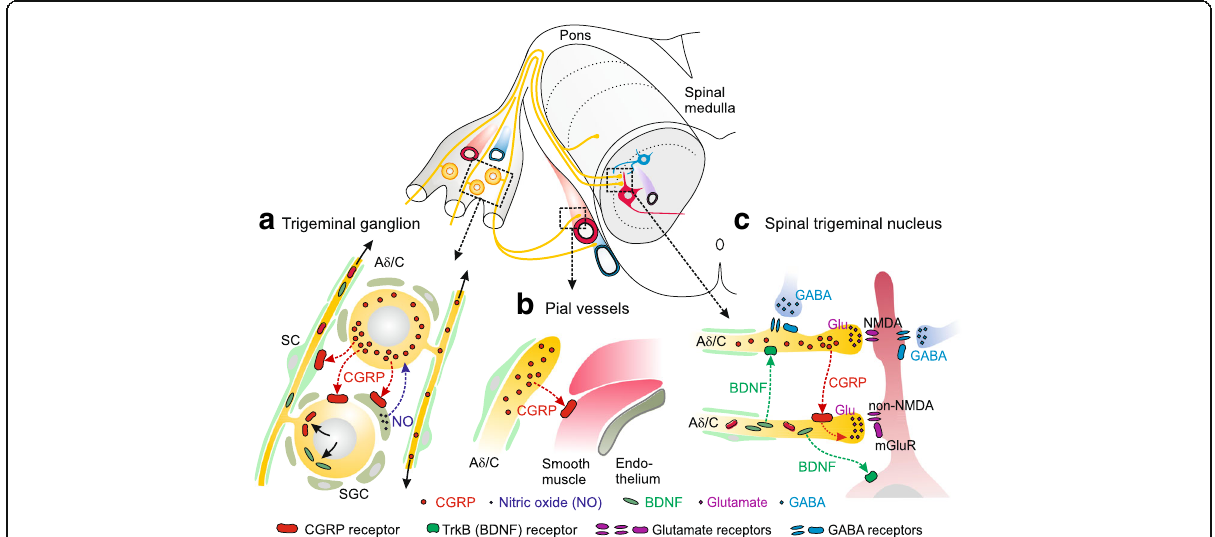
Fig. 2 Scheme of signalling sites for CGRP in the trigeminovascular system. In the trigeminal ganglion ( a ) CGRP released from neurons may signal to neighbouring neurons, glial satellite cells (GSC) and possibly Schwann cells (SC) expressing CGRP receptors and can thus, via gene expression, influence the production of substances, e.g. nitric oxide (NO), brain-derived neurotrophic factor (BDNF) and CGRP receptor components. These (NO) may signal back to the neurons, or (BDNF, CGRP receptors) may be transported through the central extensions of trigeminal afferents (A δ /C) to the spinal trigeminal nucleus. CGRP signalling at arterial vessels, e.g. the pial vessels of the spinal medulla ( b ), causes vasodilatation and increased blood flow. Within the spinal trigeminal nucleus ( c ) CGRP is released from central terminals of trigeminal afferents and signals most likely to other central terminals equipped with CGRP receptors, which may lead to increased neurotransmitter (glutamate) release and facilitation of nociceptive transmission. Release of BDNF may pre- and postsynaptically potentiate synaptic transmission. Neurons with inhibitory neurotransmitters (GABA) may counteract the pronociceptive synaptic